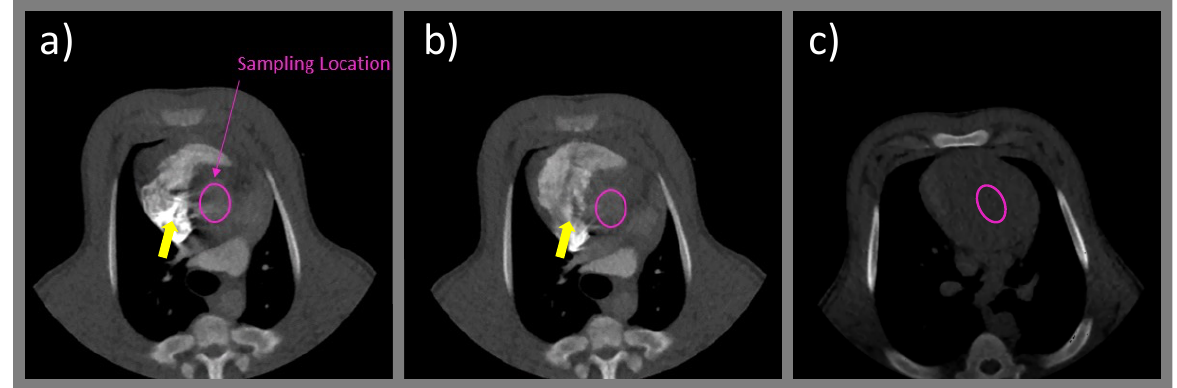
Figure 2. Streak artifacts (yellow arrows) emanating from highly attenuating contrast solution in the right atrium at the ( a ) end ‐ systolic and ( b ) end ‐ diastolic phases during the initial stage of the first pass. The artifacts spilled over into the adjacent ascending aorta (pink elliptical region), where the aortic time ‐ enhancement curve was sampled for assessment of the CO index. The two proposed baseline subtraction approaches were evaluated against the reference baseline value measured from the middle section of the left ventricle prior to contrast arrival ( c ).